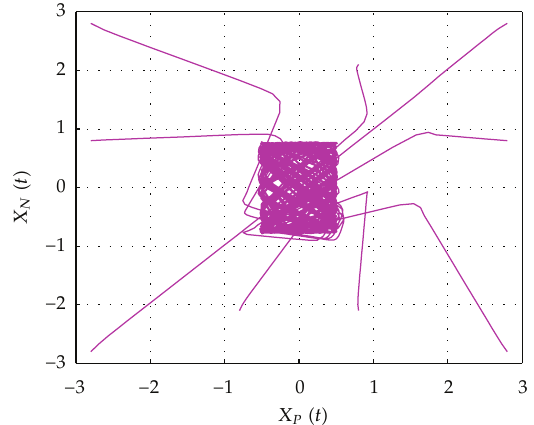
Figure 3: Phase portrait of attractivity of the unique almost periodic solution of (31) located in 𝐵 ∗